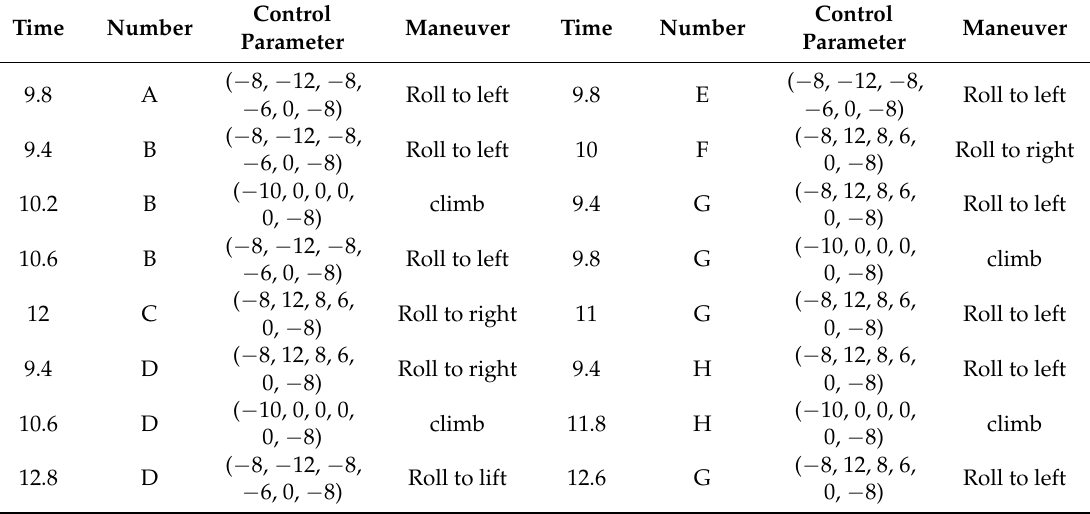
Table 11. Initial state.